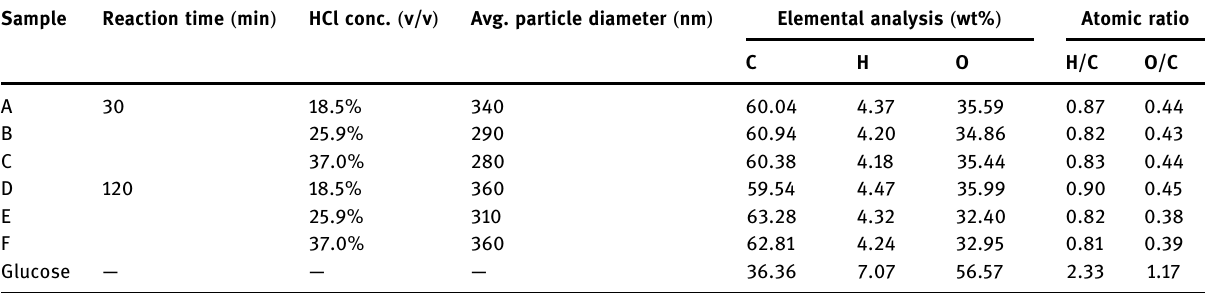
Sample Reaction time ( min